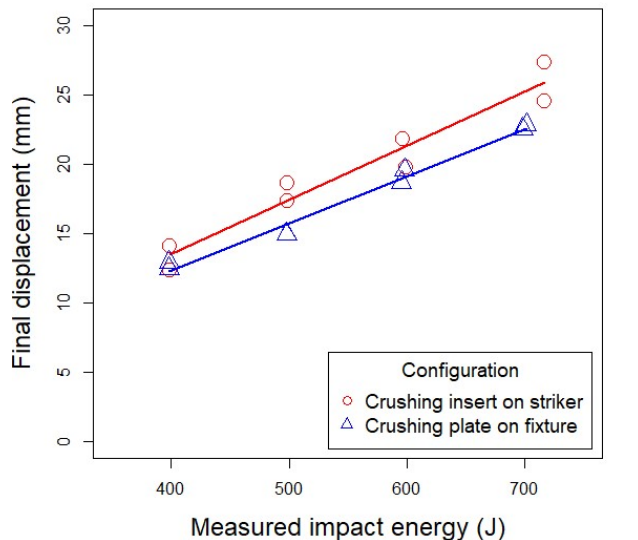
Figure 8: Linear correlation between impact energy and final crushed displacement calculated from the acquired force data.